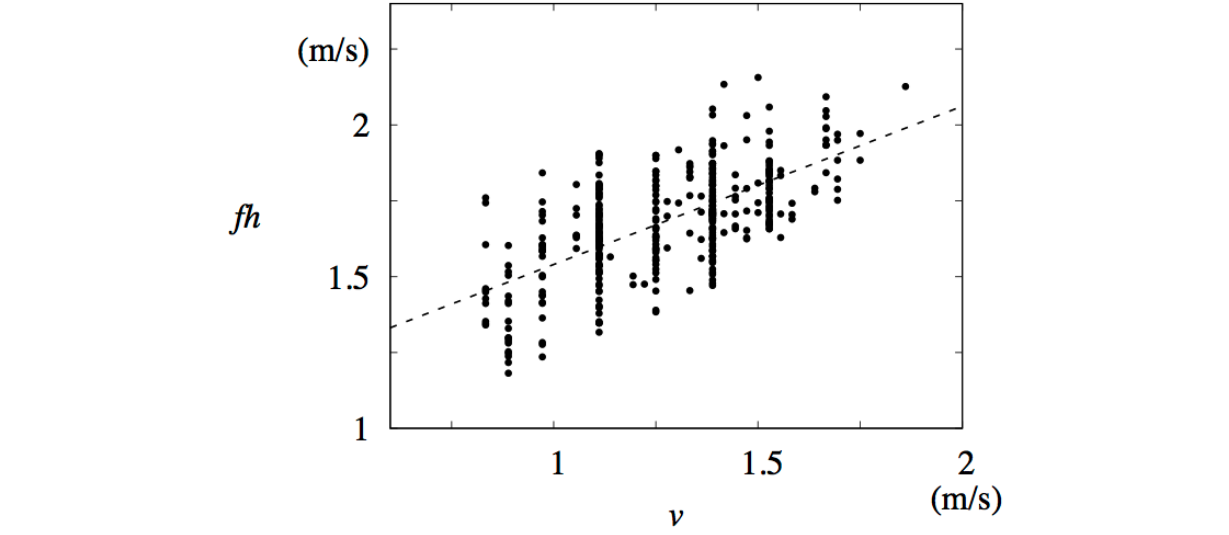
Figure 8. Step frequency, f , multiplied by height, h , plotted against average walking speed, v . Least squares fit line fh = 0.52v+1.02 (m/s) is also